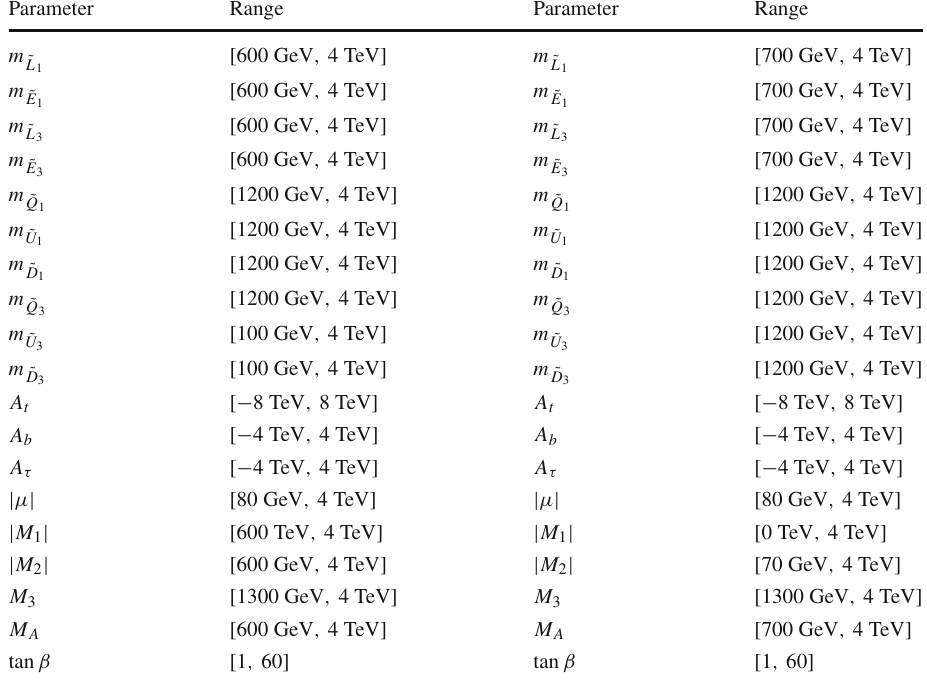
Table 8 Input parameters of the pMSSM subspace in the light stop (left) and the electroweakino (right) scenarios